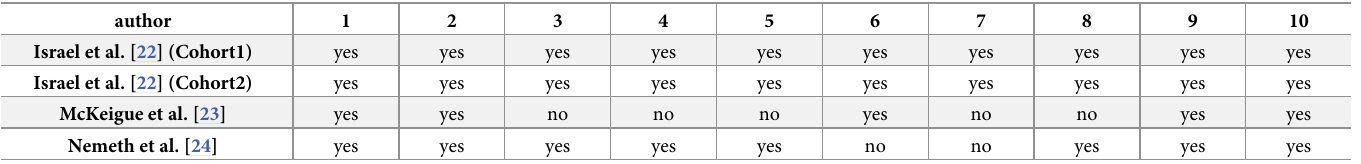
Table 3. Quality assessment of case-control